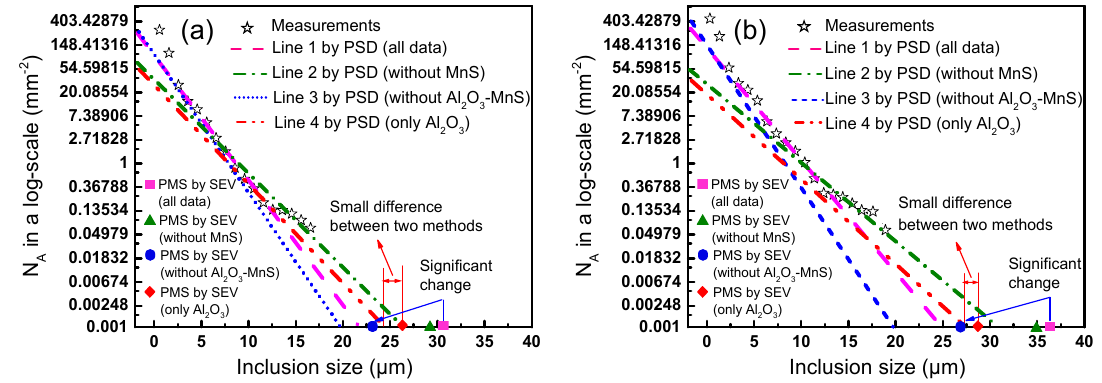
Figure 13. Comparison of regression lines by PSD (PMS by PSD is represented as the intersection between the line and X-axis) and PMS by SEV in different cases for ( a ) Steel A and ( b ) Steel B.